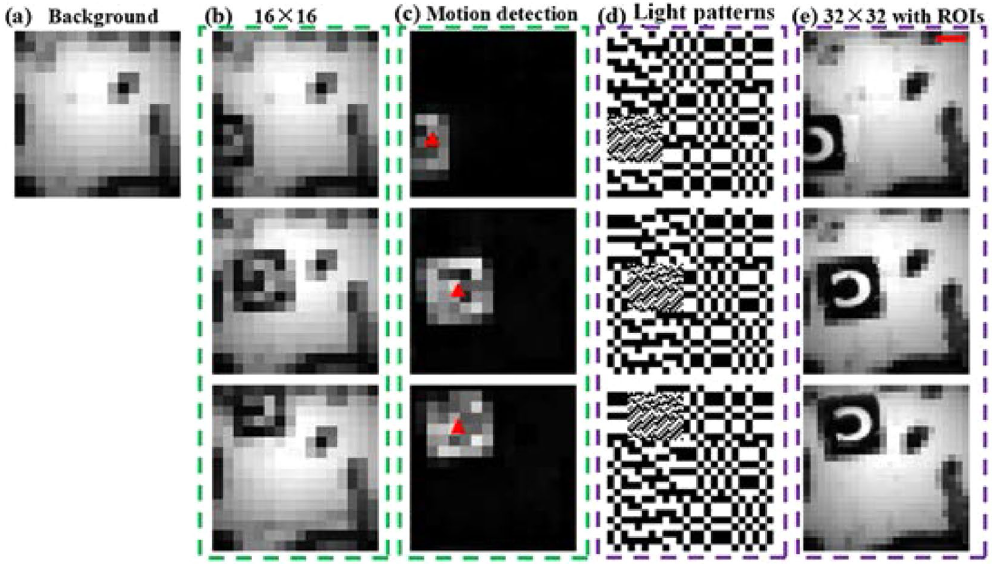
Figure 6. Experimental results for the single-pixel video with an intelligent and dynamic ROI. (a ) The background item was collected in advance (at a resolution of 16 × 16). ( b ) The low-resolution single-pixel video (16 × 16) used to quickly detect moving targets. ( c ) Background difference between ( a , b ), where the small red triangle is the center position of the moving target estimated in ( c ) by a series of image processing operations. ( d ) Speckle pattern for generating the next frame based on the position and velocity of the moving target in ( c ). ( e ) The high-resolution single-pixel video (32 × 32) with ROIs, and the scale bar in red = 2 mm. ( b – d ) All include three sets of frames taken from the single-pixel video in Supplementary Video